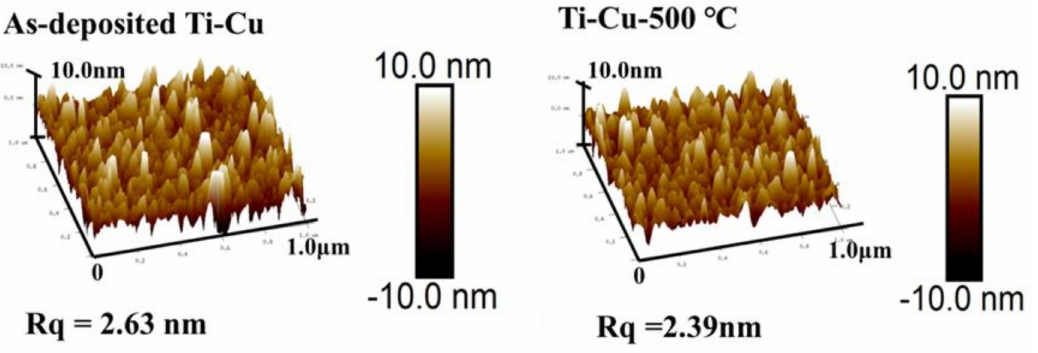
Figure 7. Surface morphology and corresponding root mean squared surface roughness ( R q ) evaluated by AFM for the Ti–Cu coatings before (as-deposited) and after annealing at 500 ◦ C (Ti–Cu- 500 ◦ C). The coatings were deposited on silicon